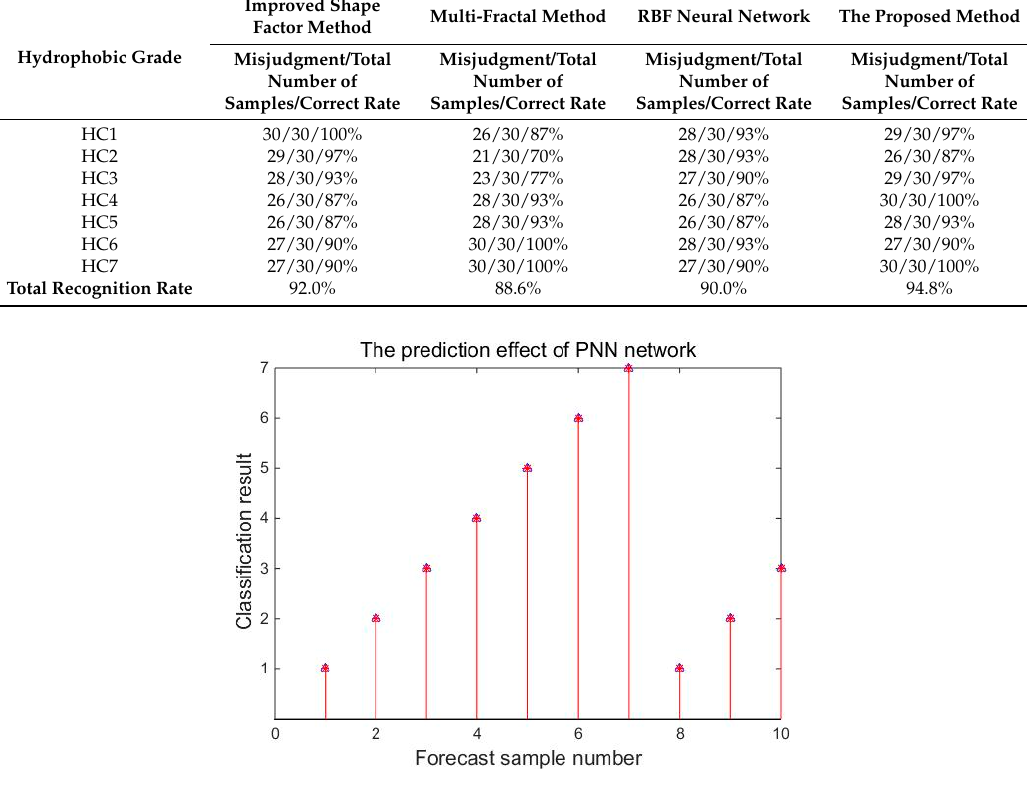
Figure 12. Prediction effect of the PNN.